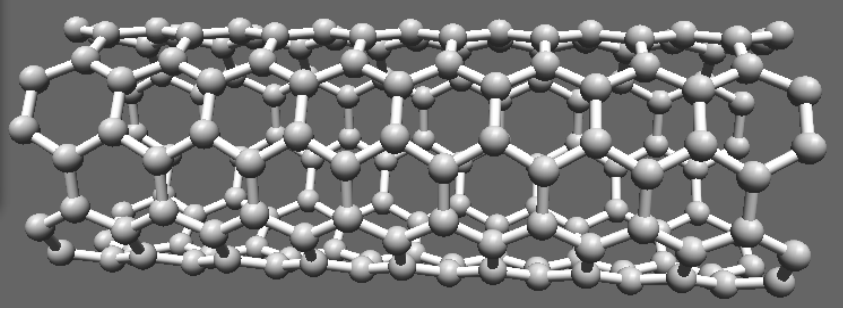
Figure 1. Single wall carbon